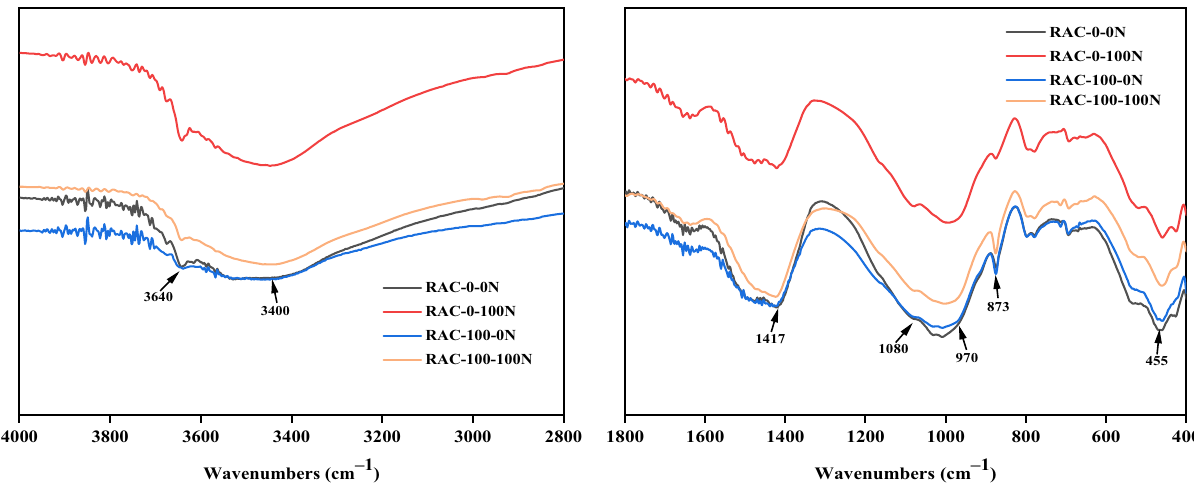
Figure 10: Function groups analysis on RAC subjected to salt - frost cycles.